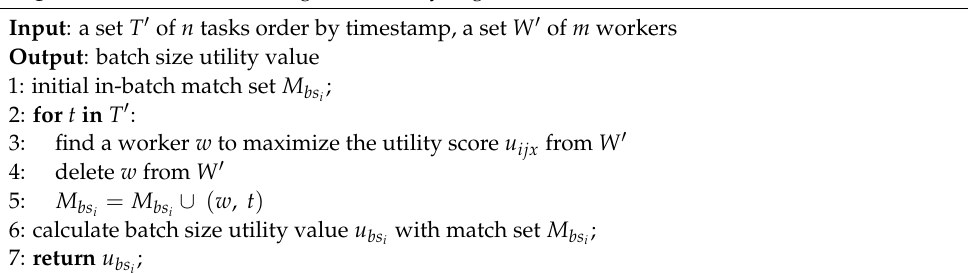
Algorithm 1 Pseudo Matching with Greedy